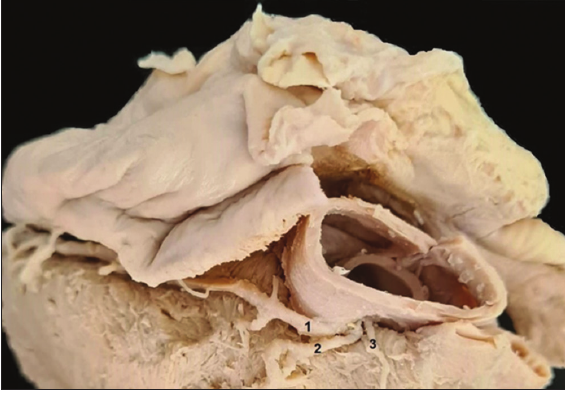
FIGURE 2. Supernumerary cardiac arteries (1. right coronary artery, 2. third coronary artery, and 3. fourth coronary